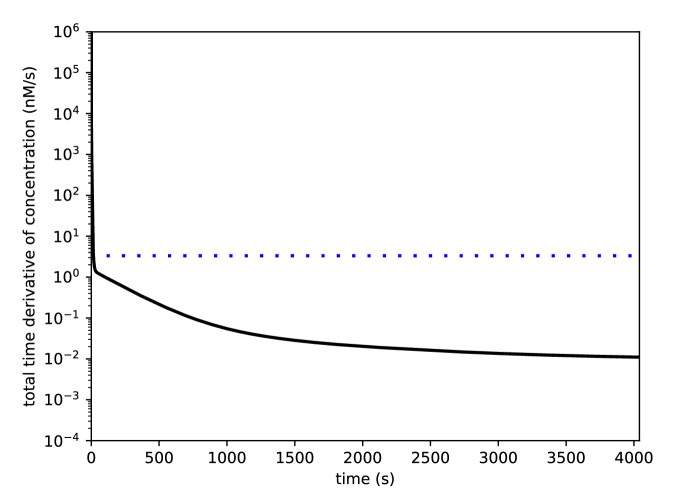
1 hr of simulation without inputs is sufficient to obtain a steady state.The model was run for 4040 s without inputs. The absolute values of the time derivatives for each molecular species were determined, and the black curve shows the sum of these derivatives (nM/sec) across the species. The dashed blue line shows the concentration derivative value that corresponds to a change of one molecule/sec in a spine of volume 0.5 μm3.